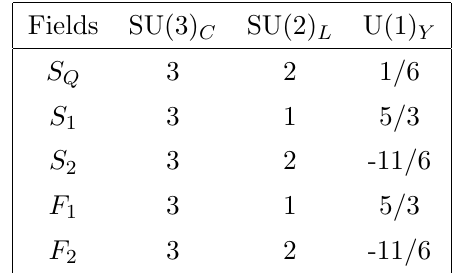
Table 3 . Quantum numbers of the new (cid:12)elds given in model 5 (see (cid:12)gure